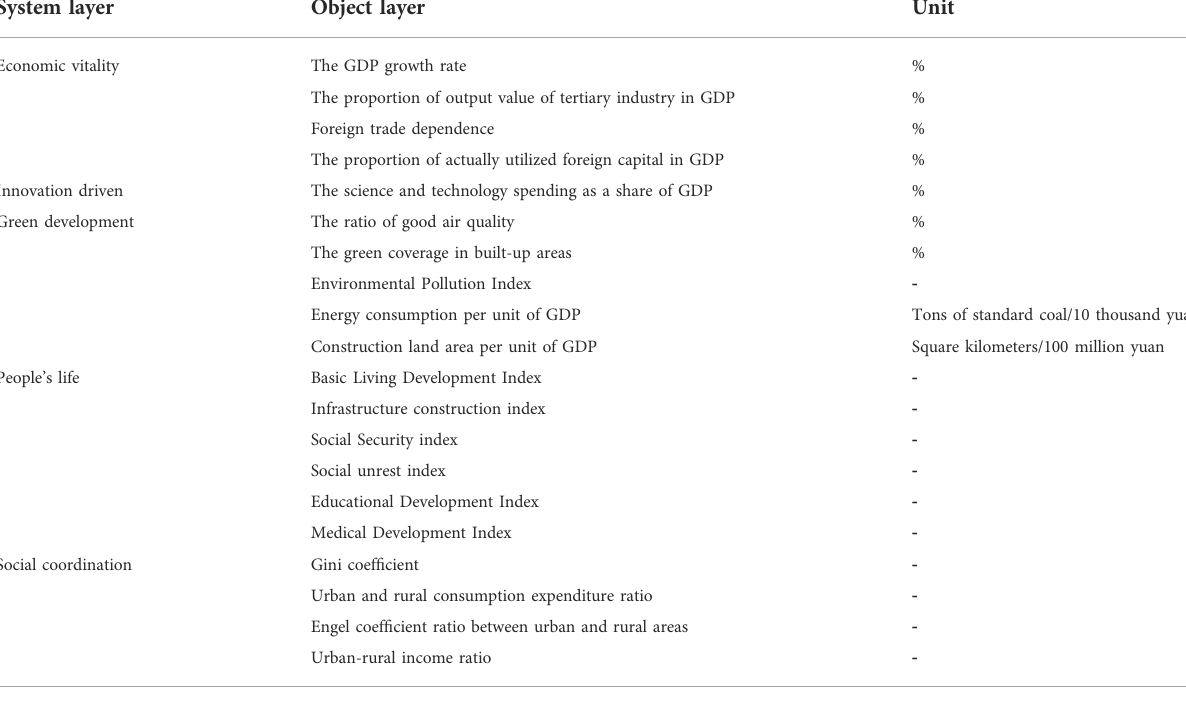
TABLE 2 High quality economic development indicator system.